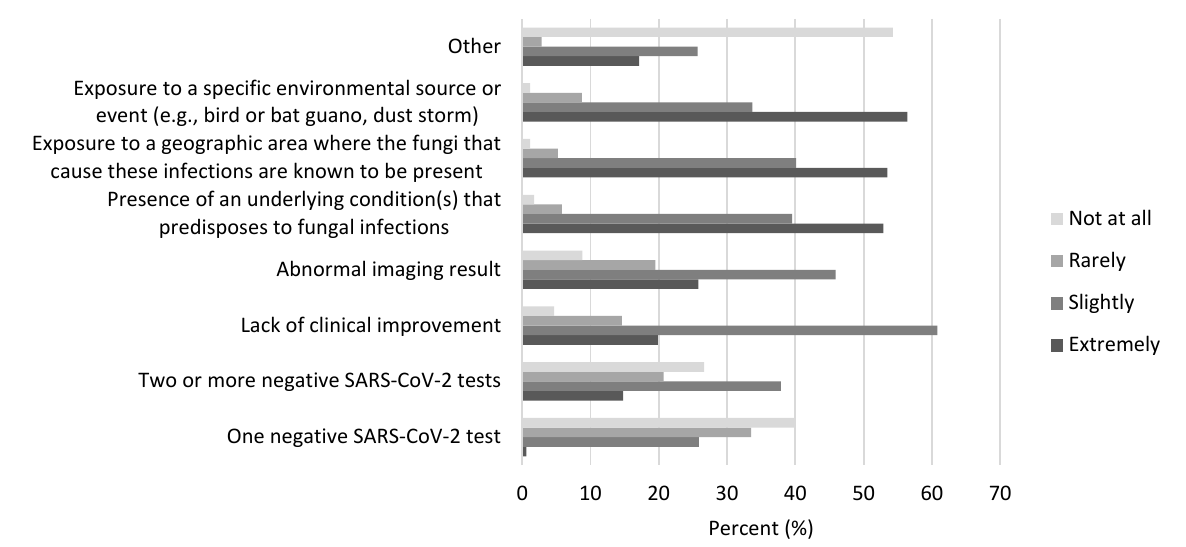
Figure 2. Infectious diseases physicians’ responses to the question “When considering a patient with possible COVID-19, how would each of the following influence your decision to test for coccidioidomycosis, histoplasmosis, blastomycosis or cryptococcosis?”.